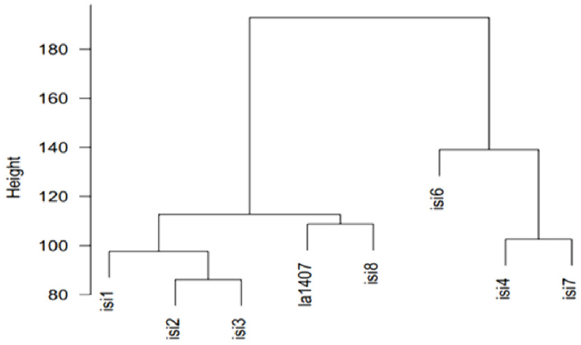
Figure 1. Dendrogram of the founders obtained by Genotyping By Sequencing approach.